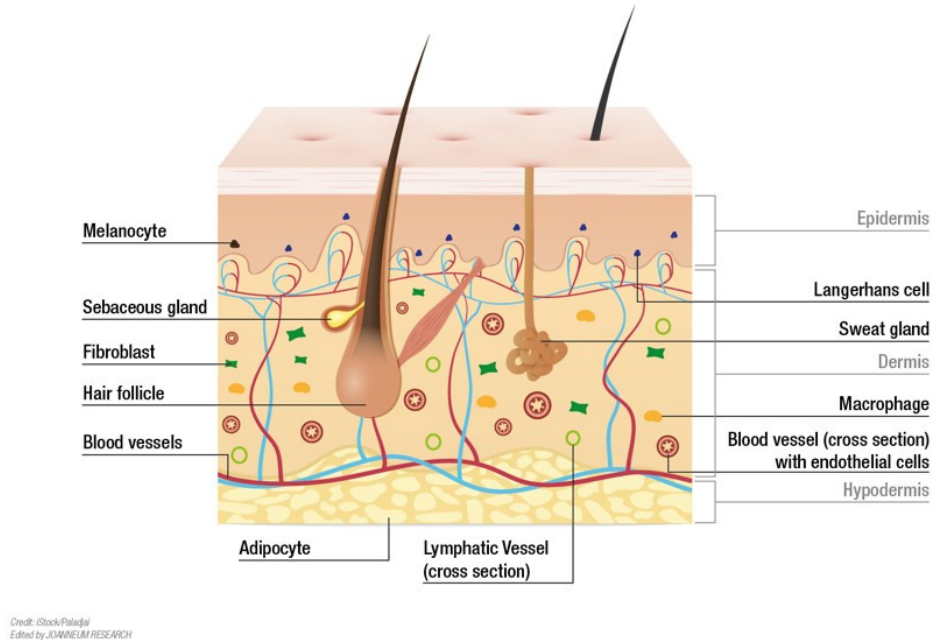
Figure 1. Structural details of human skin. The skin is composed of three distinct layers: the epidermis, dermis and hypodermis. The epidermis provides a barrier to pathogen invasion and regulates the amount of water released from the body. The dermis is tightly connected to the epidermis by the basement membrane; the dermis primarily consists of extracellular matrix, which is produced by fibroblasts. The dermis can be separated into two distinct layers, the superficial layer adjacent to the epidermis (papillary dermis) and a thicker layer below (reticular dermis). It also contains mechanoreceptors, thermoreceptors, hair follicles, sweat glands, sebaceous glands, lymphatic vessels, nerves and blood vessels. Those blood vessels provide nutrients and waste removal for both dermal and epidermal compartment [10].